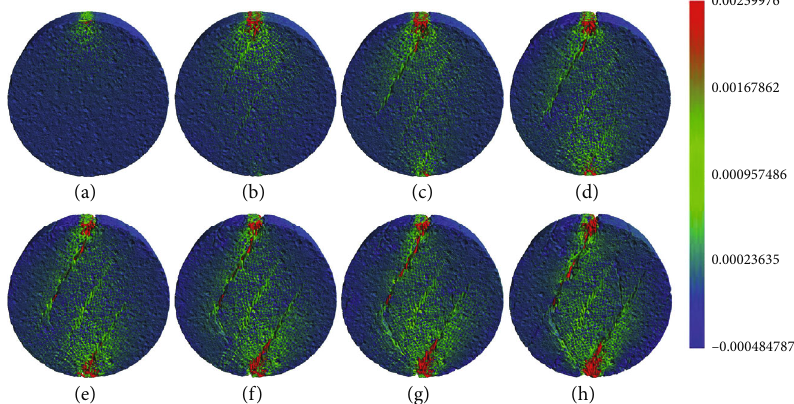
Figure 16: Diagram of the failure process of solid bond elements inside the model at 60 ° bedding inclination angle. The color bar represents the magnitude of the solid bond force (kN).